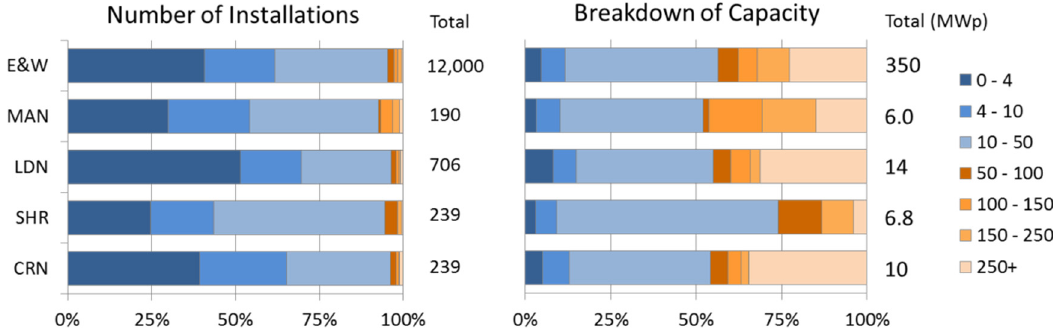
Figure 9. Breakdown of non ‐ domestic PV installations by number and capacity (MWp).